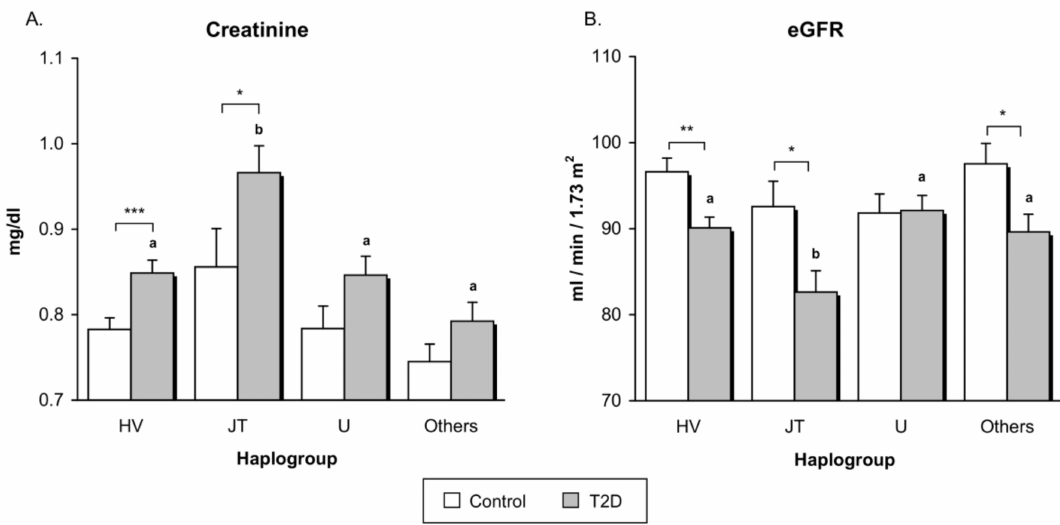
Figure 2. Assessment of renal function in healthy volunteers and type 2 diabetic patients subdivided by mitochondrial haplogroup. ( A ) Concentrations of serum creatinine; ( B ) Levels of estimated glomerular filtration rate (eGFR). White bars correspond to controls, while grey bars represent type 2 diabetic patients. * p < 0.05; ** p < 0.01; *** p < 0.001 in controls vs. type 2 diabetic subjects. Letters indicate significant differences among type 2 diabetic patients with different haplogroups ( p < 0.05) when compared by means of one-way ANOVA followed by Student-Newman-Keuls post-hoc test (i.e., bars tagged with the same letter do not differ significantly from each other, while bars with no letter in common are significantly different from each other, ( p < 0.05)). Abbreviations: